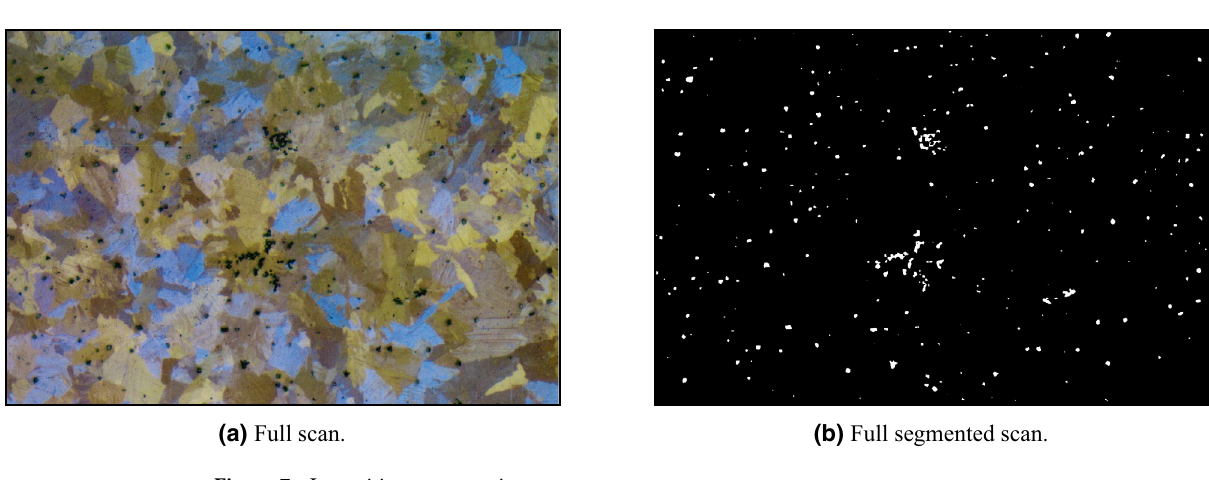
Figure 7. Impurities